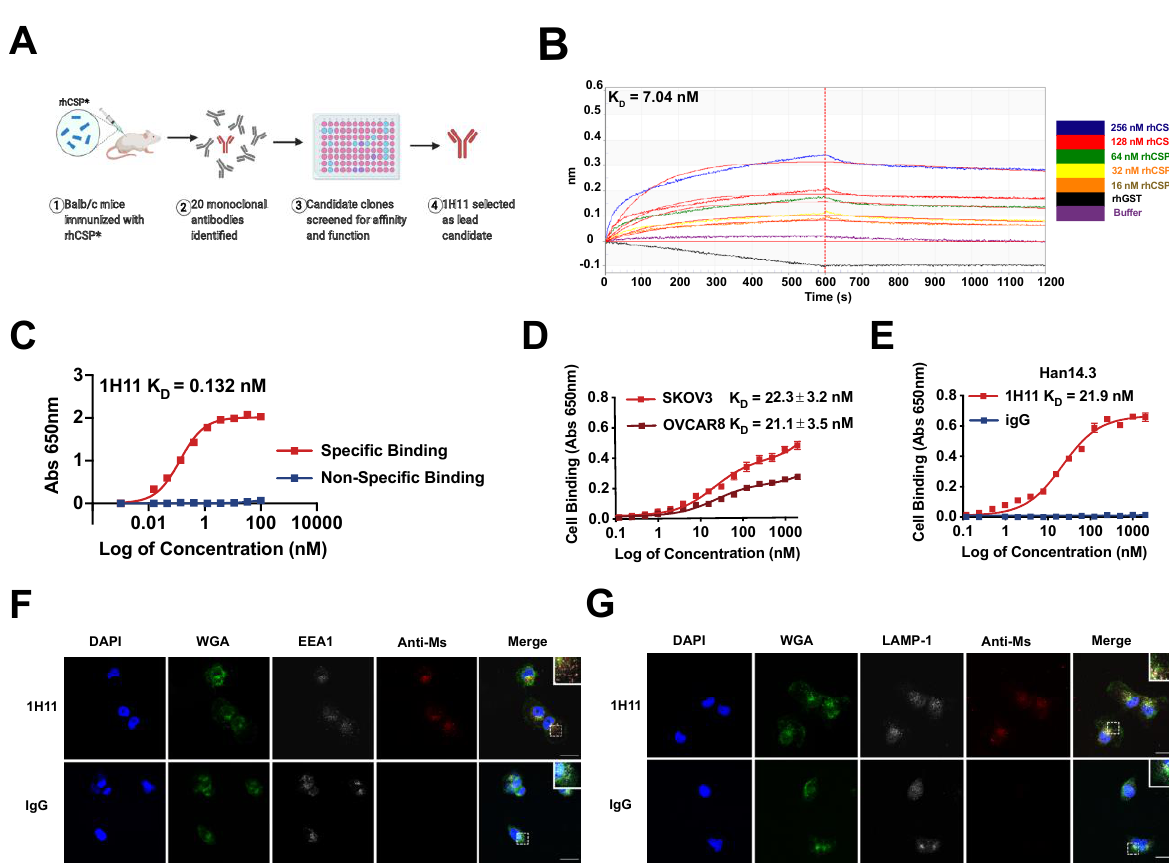
Figure 2. 1H11 generation and characterization. ( A ) A workflow schematic of 1H11 development. ( B ) 1H11 shows high binding affinity and specificity to recombinant CSP (rhCSP*) by kinetic binding assay and ( C ) in proteo ELISA. ( D , E ) Cell binding assays were performed to evaluate 1H11 binding to human and murine native CSP by incubating ( D ) human CSP+ OC cell lines, SKOV3 or OVCAR8, or ( E ) murine CSP+ cell line, Han14.3, with serial dilutions of 1H11 or IgG. ( F , G ) Antibody internalization was evaluated by incubating OVCAR8 cells with 1H11 or IgG for 30 min, then co-staining for markers of endocytosis, ( F ) EEA1 or ( G ) LAMP-1. Immunofluorescence imaging shows rapid internalization of 1H11 compared to IgG. Representative images are shown. Blue, DAPI; green, WGA; white, endosome markers (EEA1 or LAMP1); red, treatment condition (1H11 or IgG). Scale Bar = 25 µm. Errors bars indicate mean ± SEM.